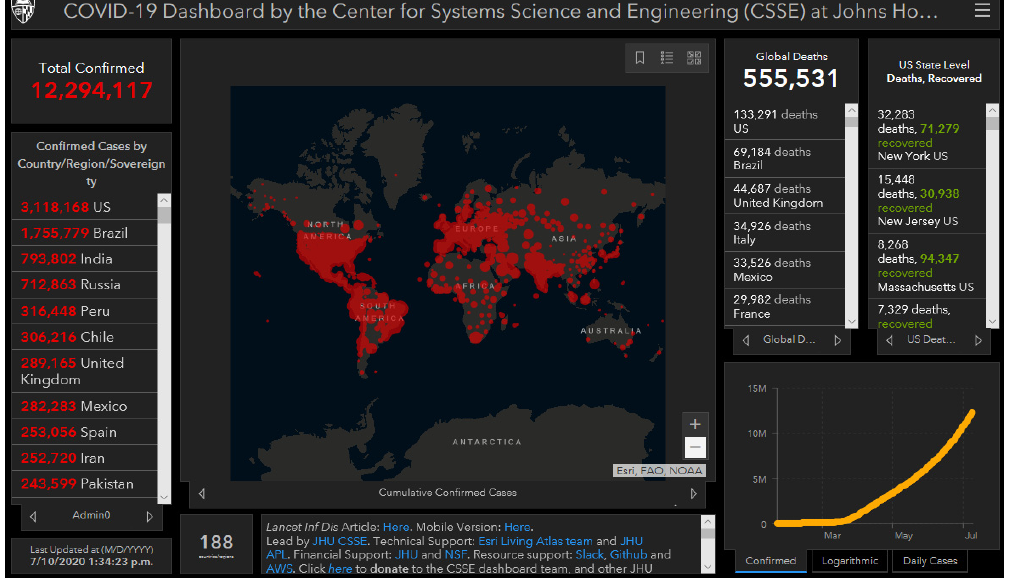
Figure 7. Visualization of the global development of the COVID-19 epidemic [45].